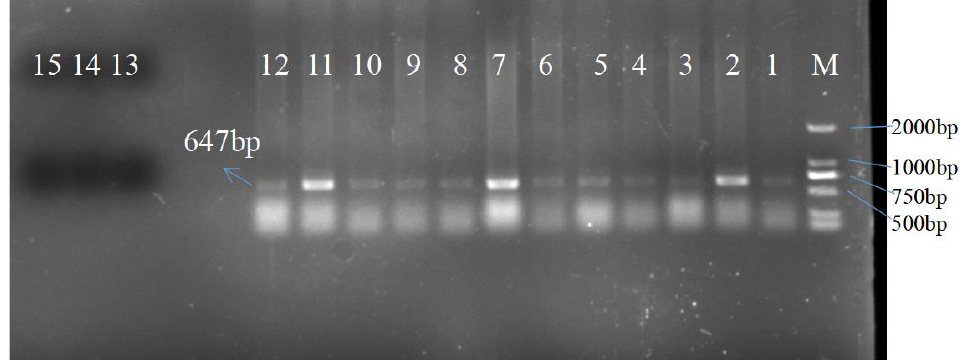
Figure A1. PCR-based validation of Pm in different lung samples from goats in different groups. Lane 1 – 12, lung samples from the Pm-infected group goats. lanes 13 – 15, lung samples from the CK group goats. M — Marker D2000.